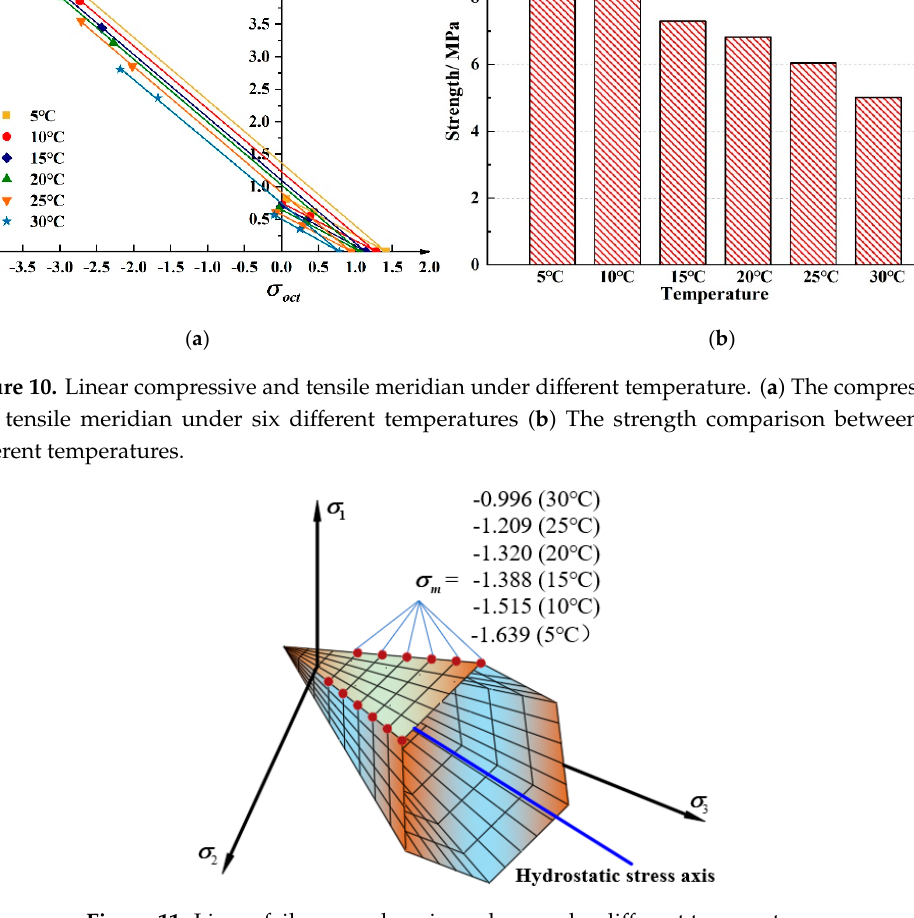
Figure 11. Linear failure envelope in π plane under different temperatures.